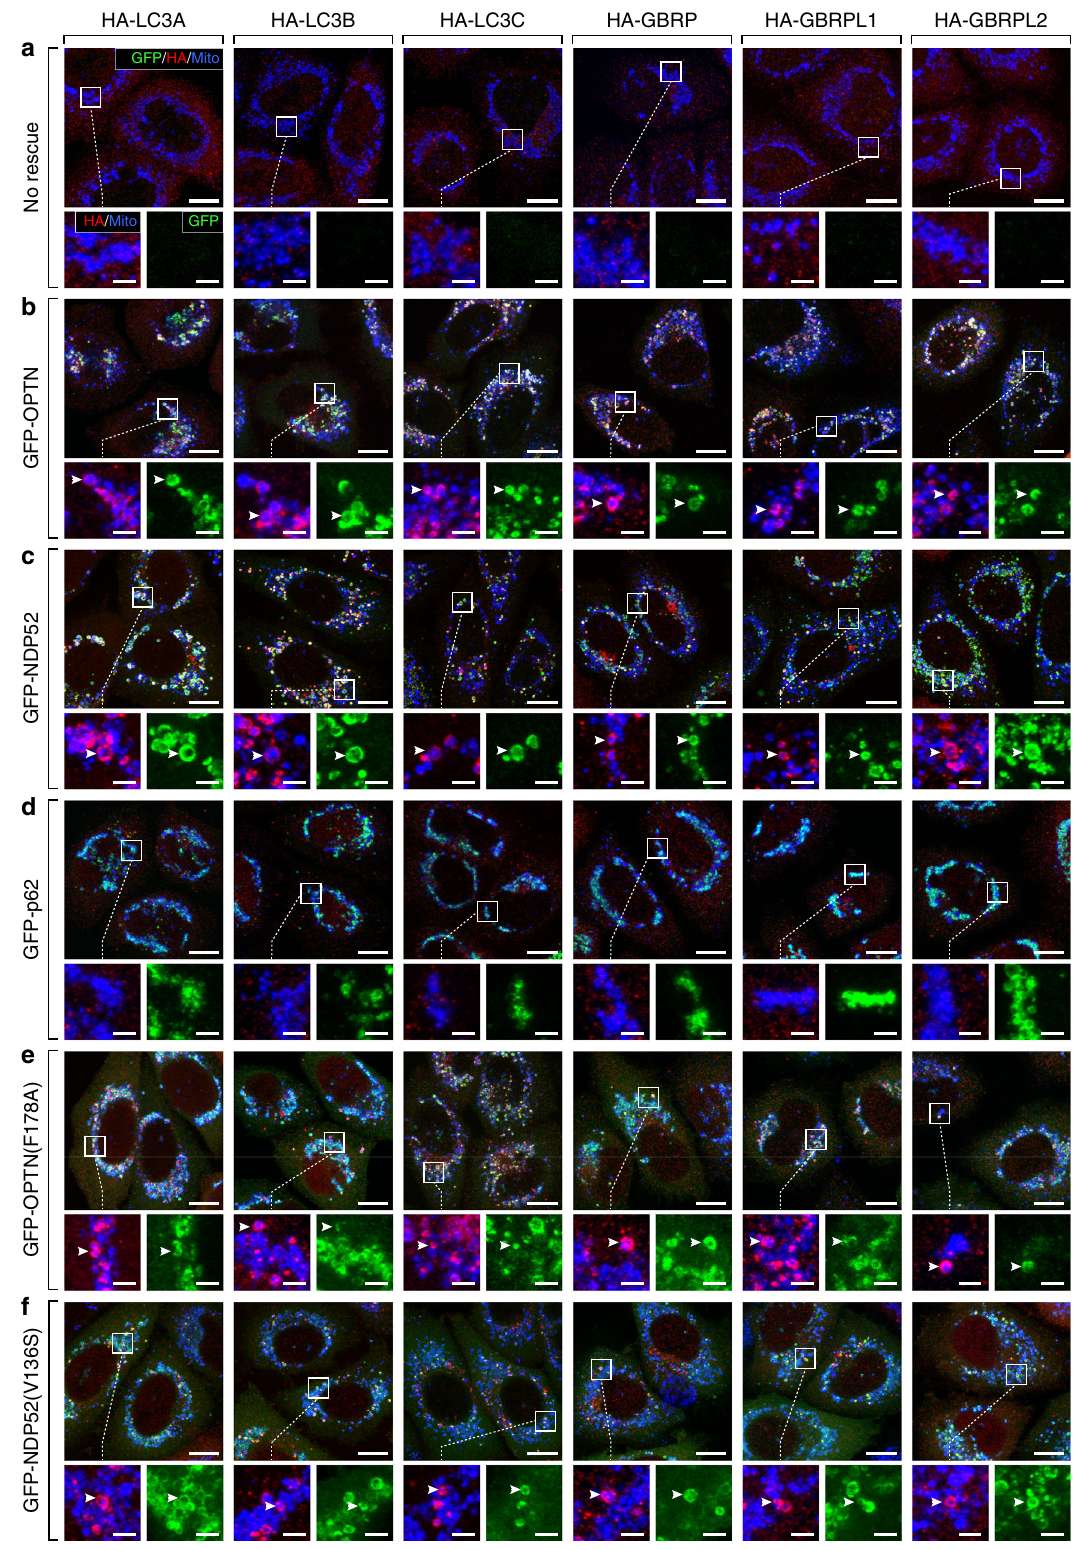
Fig. 1 The LIR motif within autophagy receptors is dispensable for Atg8 recruitment during PINK1/Parkin mitophagy. a – f Representative immuno fl uorescence images of penta KO HeLa cells stably expressing untagged Parkin and either HA-LC3A, HA-LC3B, HA-LC3C, HA-GBRP, HA-GBRPL1 or HA-GBRPL2, without receptor expression ( a ), or rescued by co-expression of either GFP-OPTN ( b ), GFP-NDP52 ( c ), GFP-p62 ( d ), GFP-OPTN(F178A) ( e ) or GFP-NDP52(V136S) ( f ); immunostained for HSP60, HA & GFP after 3 h OA treatment. Atg8-positive mitochondria are indicated by arrowheads. Scale bars: overviews, 10 µ m; insets, 2 µ